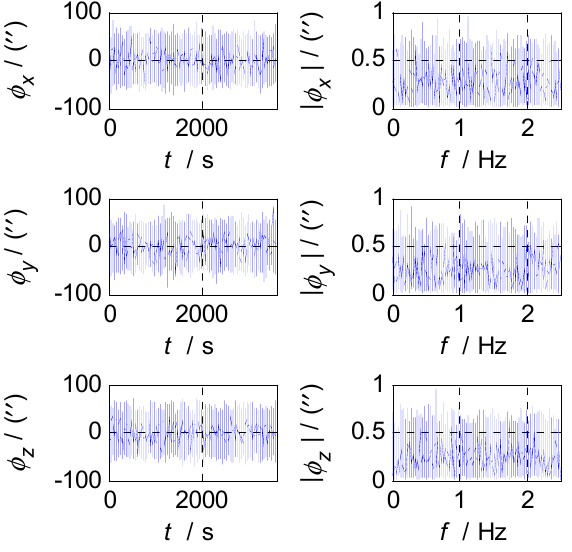
Figure 3. Attitude errors and frequency characteristics of CNS.